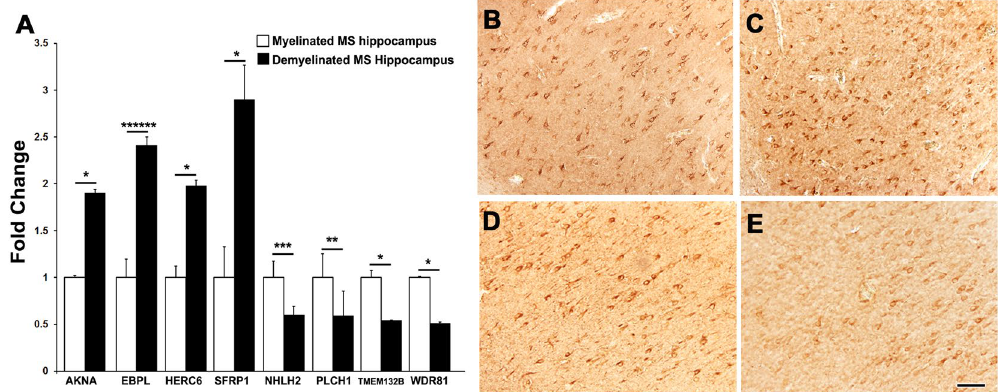
Figure 4. Inverse correlation between DMP and mRNA levels of target genes. RT-PCR analysis shows significant increases in mRNA levels of AT-hook transcription factor (AKNA), Emopamil Binding Protein Like (EBPL), HECT domain and RCC1-like domain containing protein 6 (HERC6), and Secreted frizzled related protein 1 (SFRP1) in demyelinated MS hippocampus (n = 4) compared to myelinated MS hippocampus (n = 4). Hyper-methylation within Nescient helix-loop-helix 2 (NHLH2), Phospholipase C eta 1 (PLCH1), Transmembrane protein 132B (TMEM132B), and WD repeat domain 81 (WDR81) following demyelination led to significant decreases in mRNA levels. Immunohistochemistry showing cellular expression of SFRP1 and PLCH1 in myelinated ( B , D ) and demyelinated hippocampus ( C , E ), with predominant expression in hippocampal neurons. Scale Bars: B–E: 30 μ m; Error bars indicate + S.E.M.; * p < 0.05, ** p < 0.005, *** p < 0.0005, ***** p <